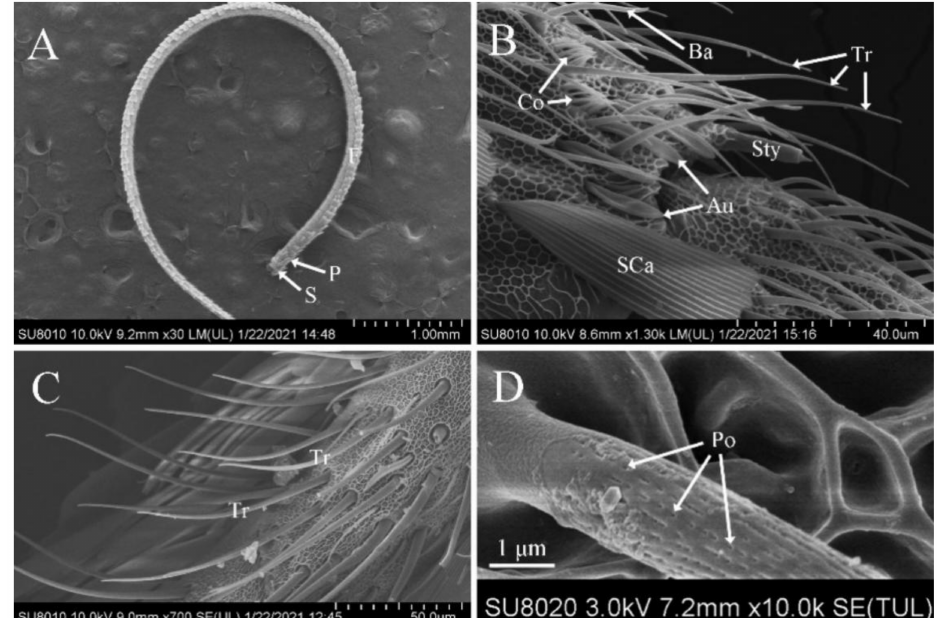
Figure 1. Scanning electron micrographs of the antennae and trichodea sensilla in Dioryctria rubella . ( A ) General morphology of antennae; ( B ) various sensilla on the antennae; ( C ) sensilla trichodea (Tr); ( D ) close-up of sensilla trichodea. Au, sensilla auricillica; Ba, sensilla basiconica; Co, sensilla coeloconica; F, flagellum; P, pedicel; Po, pore; S, scape.